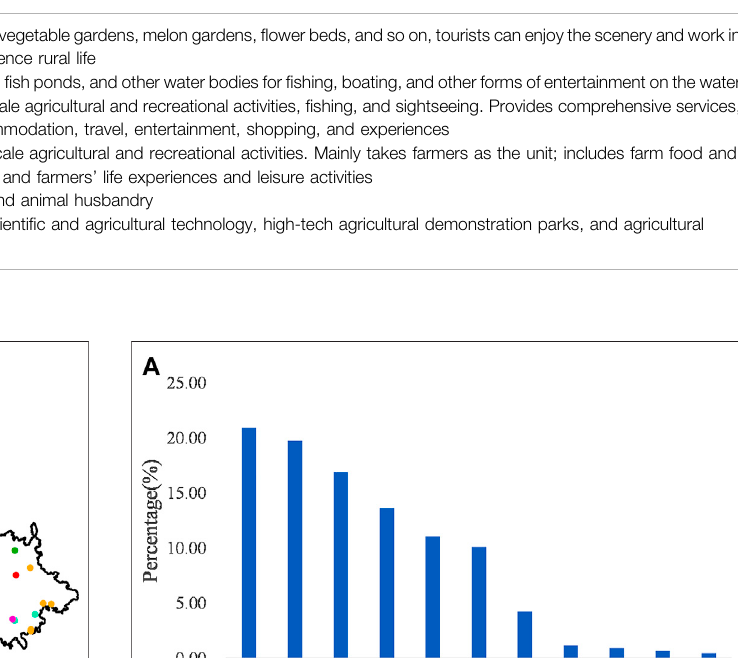
TABLE 2 | Types and characteristics of leisure agriculture. Type